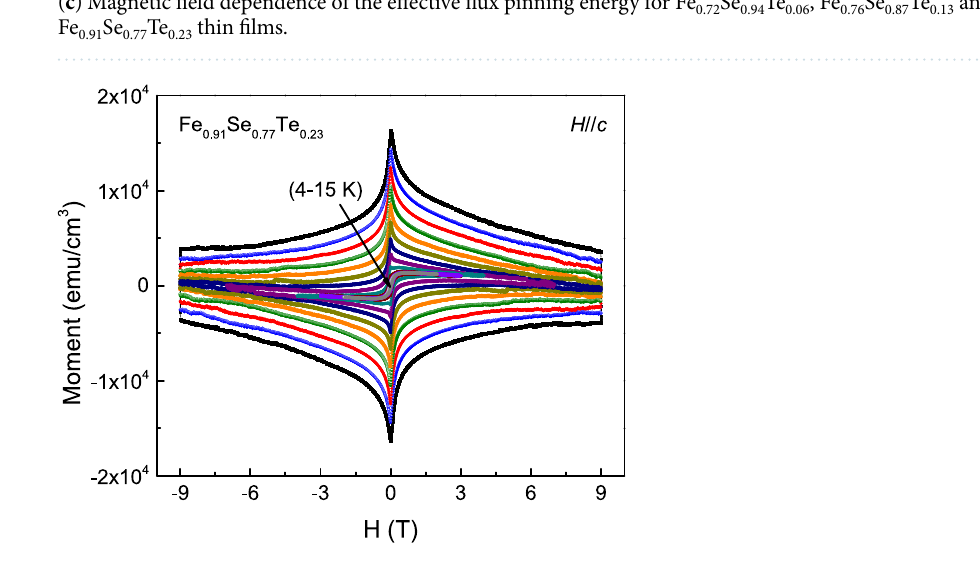
Figure 6. Magnetic hysteresis loops of Fe 0.91 Se 0.77 Te 0.23 thin film at various temperatures in magnetic field parallel to the c